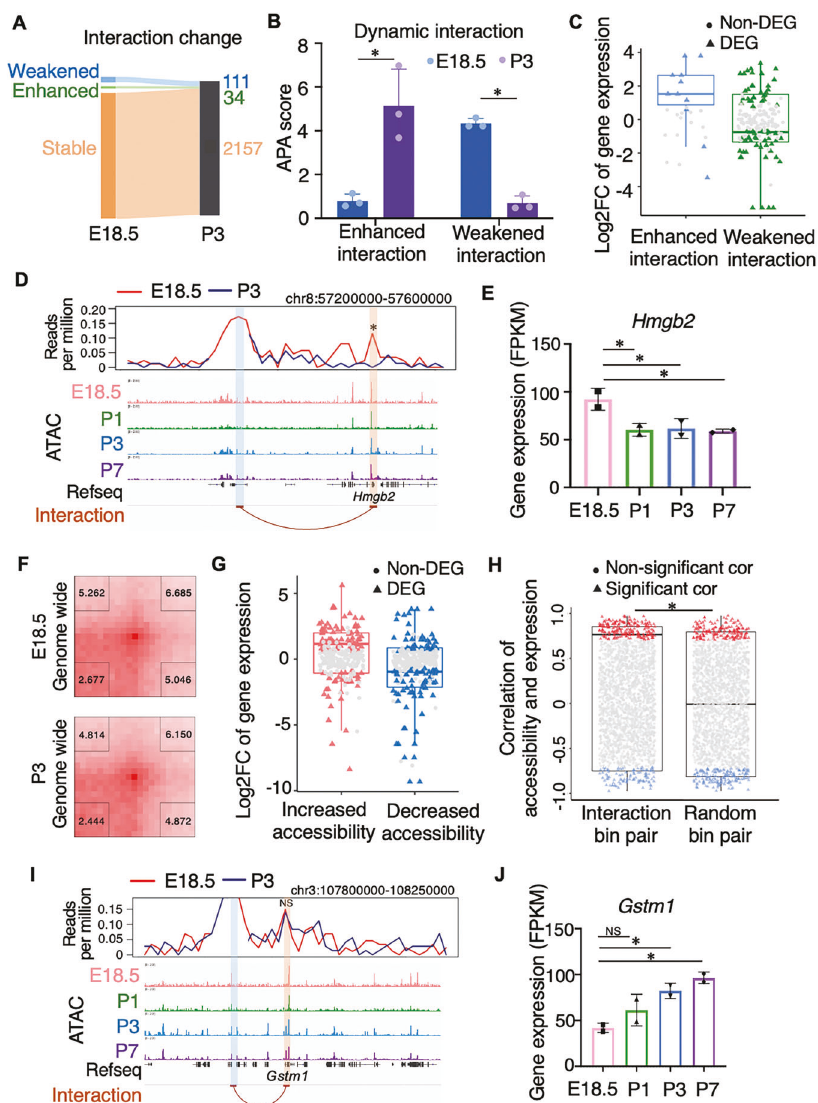
Fig. 4 Dynamics of chromatin high-order structure mediates perinatal transcriptome. A Sankey diagram shows the number of chromatin interactions that are weakened, enhanced or stable from the late fetal to neonatal cardiomyocytes. B APA scores of dynamic interactions in the late fetal and neonatal cardiomyocytes ( n = 3, two-tailed Student ’ s t -test, P = 0.0116 for APA scores of enhanced interactions in E18.5 vs. P3; n = 3, Wilcoxon rank sum test, P = 0.049 for APA scores of weakened interactions in E18.5 vs. P3. * indicates P < 0.05). C Boxplot shows dynamic interactions was accompanied by corresponding transcription changes (center line, median; box limits, upper and lower quartiles). Colored triangles represent interactions in which differential expression genes (DEG) are located. Gray dots represent interactions in which gene expression is not signi fi cantly different (Non-DEG). D Virtual 4C interaction pro fi le at the distal element of Hmgb2 in E18.5 (red line) and P3 (blue line) cardiomyocytes. Genome browser view of chromatin accessibility is aligned vertically below. The anchor (distal element) and Hmgb2 promoter are marked with blue and orange boxes, respectively. The strength change of the interaction between them is signi fi cant ( P = 0.002, * indicates P < 0.05). E Bar plot of gene expression (right, n = 2, FDR for E18.5 vs. P1, P3, and P7 are 0.033, 0.029, and 0.019, respectively. * indicates FDR < 0.05). F Genome-wide APA measurements of stable interactions in the late fetal and neonatal cardiomyocytes. P2LL (peak to lower left) value in the lower left corner was taken as the APA score. G Log2FC of differential expression genes regulated by distal regulatory elements with increased or decreased accessibility (center line, median; box limits, upper and lower quartiles). Colored triangles represent interactions in which DEG are located. Gray dots represent interactions in Non-DEG. H Pearson correlation of chromatin accessibility and gene expression for chromatin interactions bin pairs or randomized pairs. More pairs show positive correlation (red triangles, 204 pairs at correlation ’ s P -value < 0.05) than negative correlation (blue triangles, 103 pairs at correlation ’ s P -value < 0.05). Boxplot shows the Pearson correlation of chromatin interactions or randomized pairs with signi fi cant correlation P -values (center line, median; box limits, upper and lower quartiles, Wilcoxon rank sum test, P = 2.34E-06, * indicates P < 0.05, randomized pairs mean randomly matching anchors from interactions). I Virtual 4C interaction pro fi le at the distal element of Gstm1 in E18.5 (red line) and P3(blue line) cardiomyocytes. Genome browser view of chromatin accessibility is aligned vertically below. The anchor (distal element) and Gstm1 promoter are marked with blue and orange boxes, respectively. The strength change of the interaction between them is not signi fi cant ( P = 0.6, NS indicates not signi fi cant). J Bar plot of gene expression (right, n = 2, FDR for E18.5 vs. P1, P3, and P7 are 0.2, 0.021, and 0.005, respectively. NS indicates not signi fi cant. * indicates FDR <